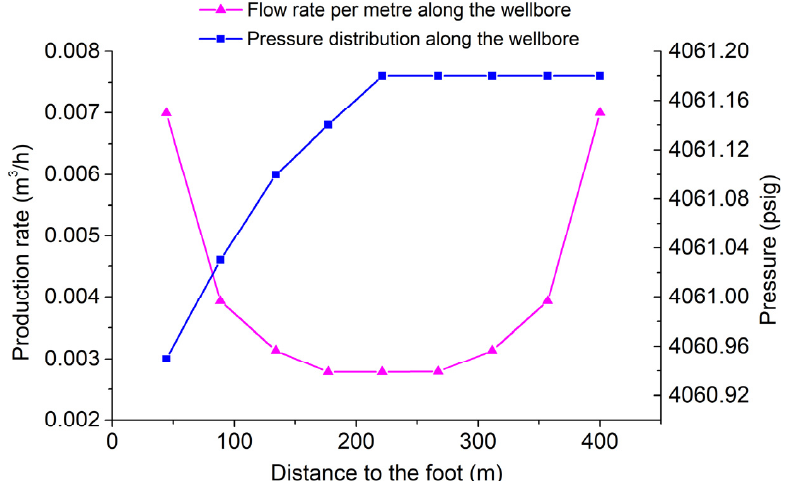
Figure 6. The 10th year fluid production and pressure distribution of horizontal well predicted using single-phase flow transient model.